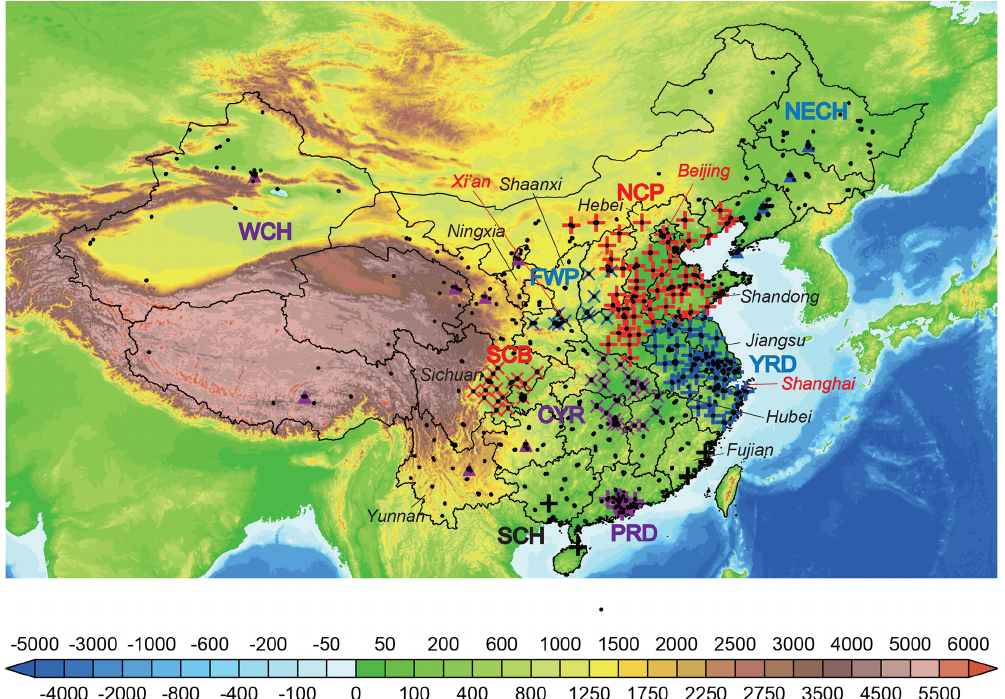
Figure 1. Site locations (black dots) of the China National Environmental Monitoring Center (CNEMC) network. Also shown are the locations of 169 major cities grouped to 9 city clusters (Table 1): the North China Plain (NCP; red pluses) cluster, the Yangtze River Delta (YRD; blue pluses) cluster, the Fenwei Plain (FWP; blue crosses) cluster, the Sichuan Basin (SCB; red crosses) cluster, the central Yangtze River (CYR; purple crosses) cluster, the Pearl River Delta (PRD; purple pluses) cluster, the northeastern China (NECH; blue triangles) cluster, the western China (WCH; purple triangles) cluster, and southern China (SCH; black pluses). The provinces mentioned in the text are labeled in black, and the three cities analyzed in Figs. 7–9 are labeled in red. The underlying figure shows terrain elevation